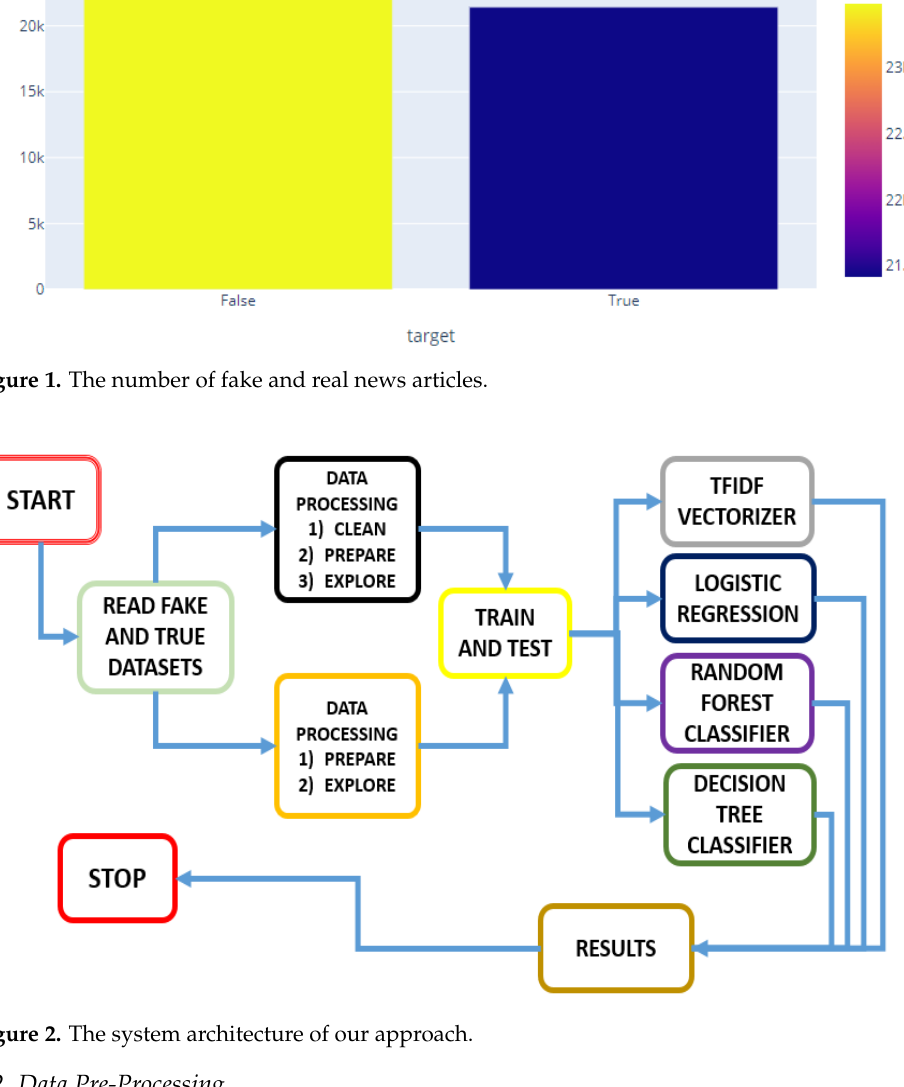
Figure 2. The system architecture of our approach.